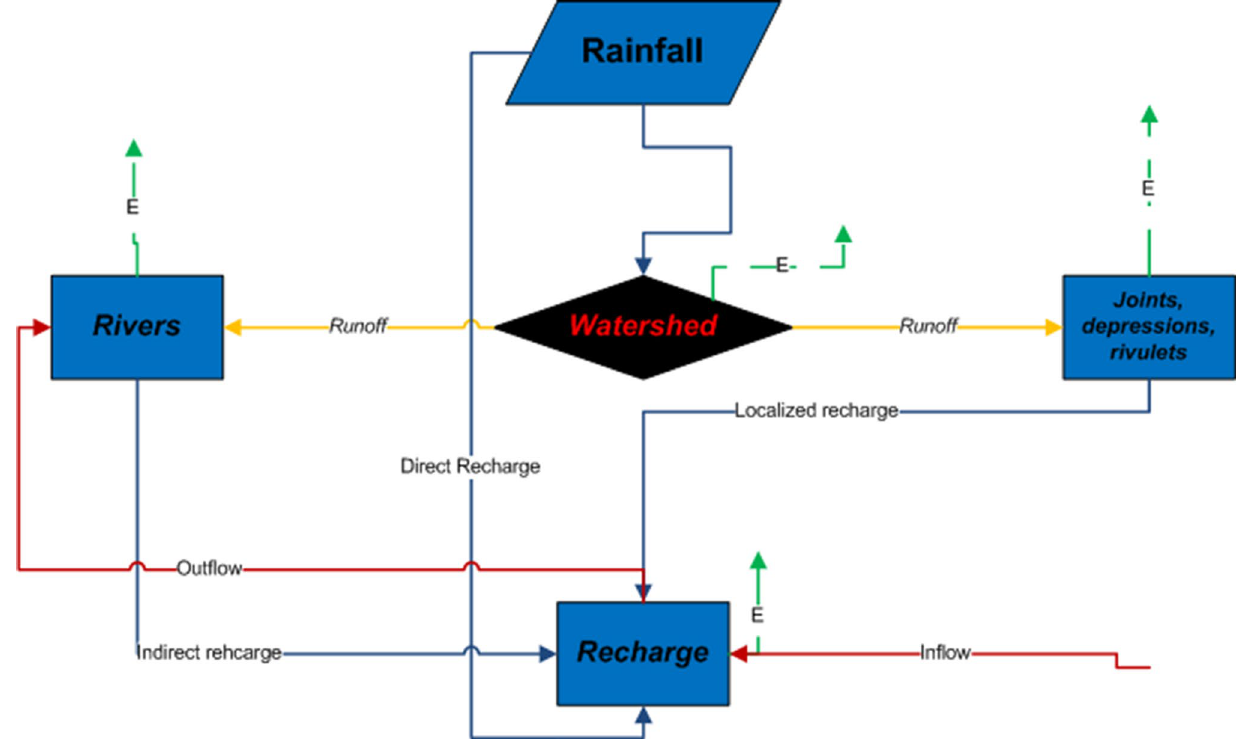
Fig. 1 Groundwater recharge mechanism (De Vries and Simmers 2002)